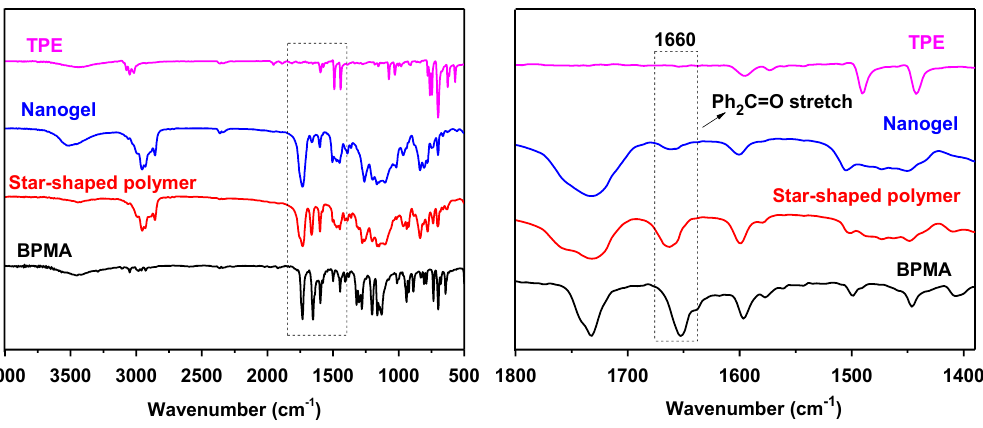
Figure 3. Successful synthesis of P(BPMA- co -ProHEMA) gel - b -PMMA confirmed by its FTIR spectrum compared with those of TPE, P(BPMA- co -ProHEMA)- b -PMMA and BPMA (left: full spectra, right: zoomed spectra).